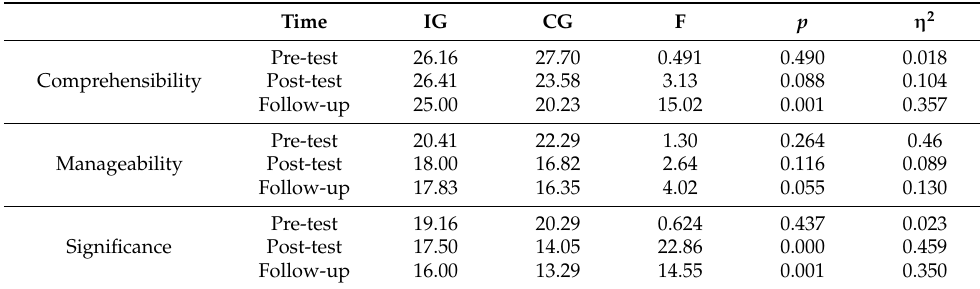
Table 5. Mean of the sense of coherence dimensions at the three time points and univariate comparison statistics in experimental and control groups.